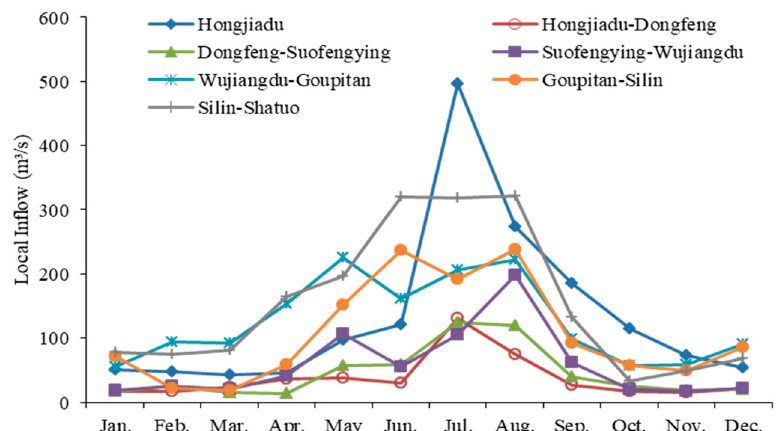
Figure 3. The monthly local inflow of each reservoir in 2016.